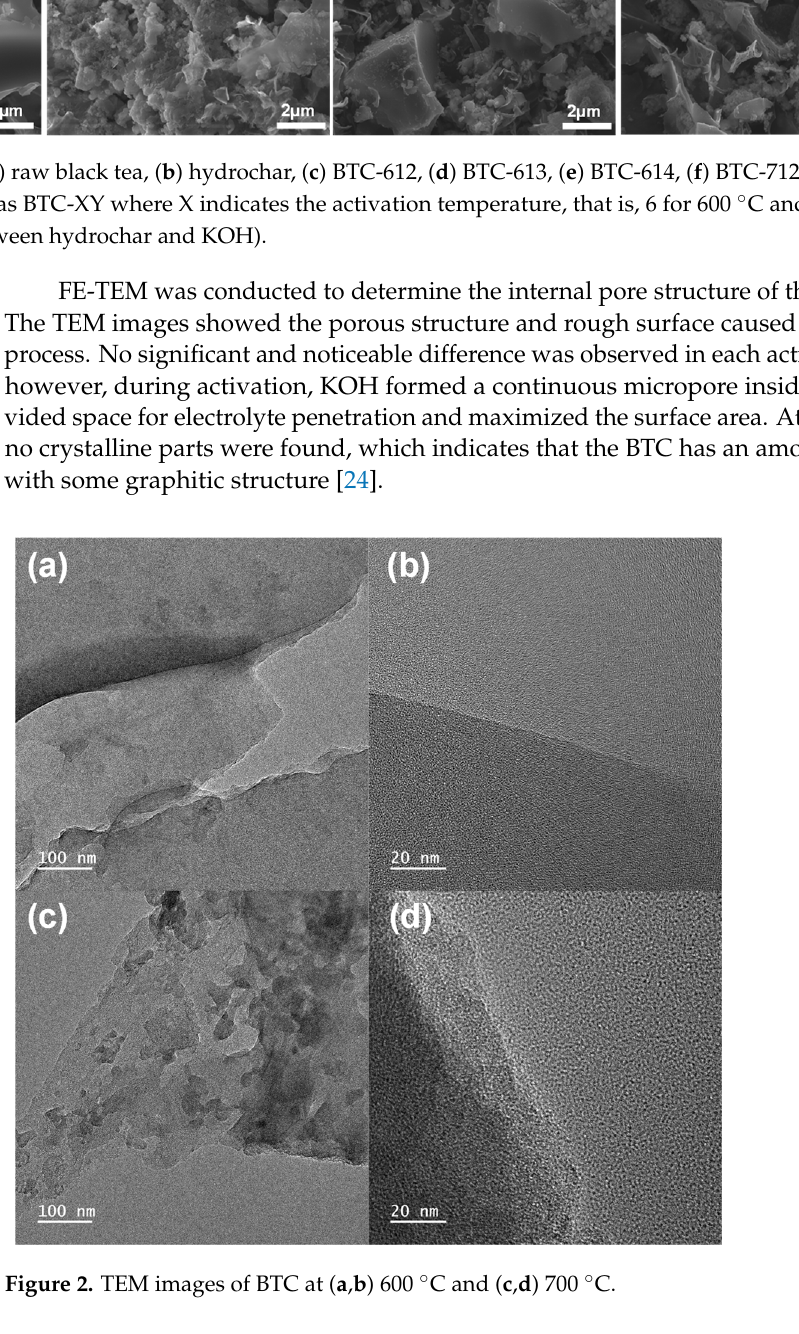
Figure 2. TEM images of BTC at ( a , b ) 600 °C and ( c , d ) 700 °C.